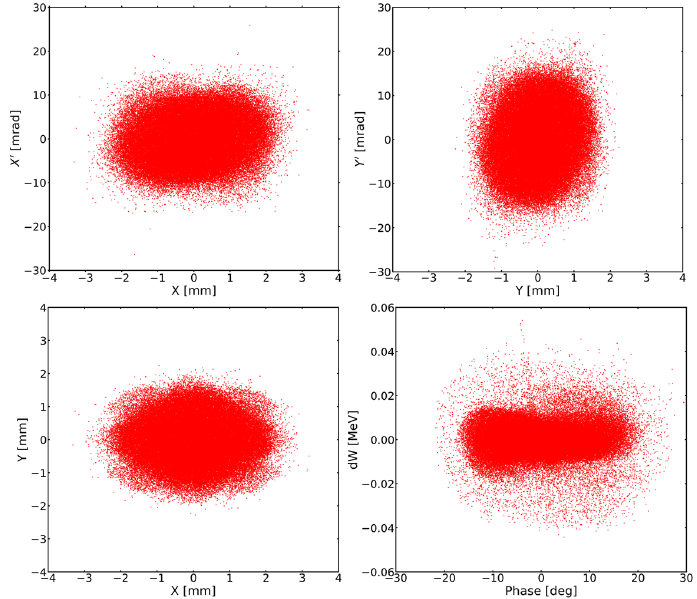
Figure 5. Particles phase-space distribution at the exit of the RFQ.